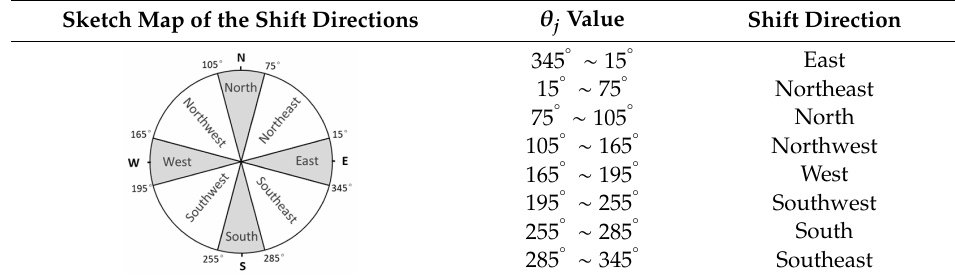
Table 1. The definition of the shift direction of the mean center in the potential vegetation ecosystem.